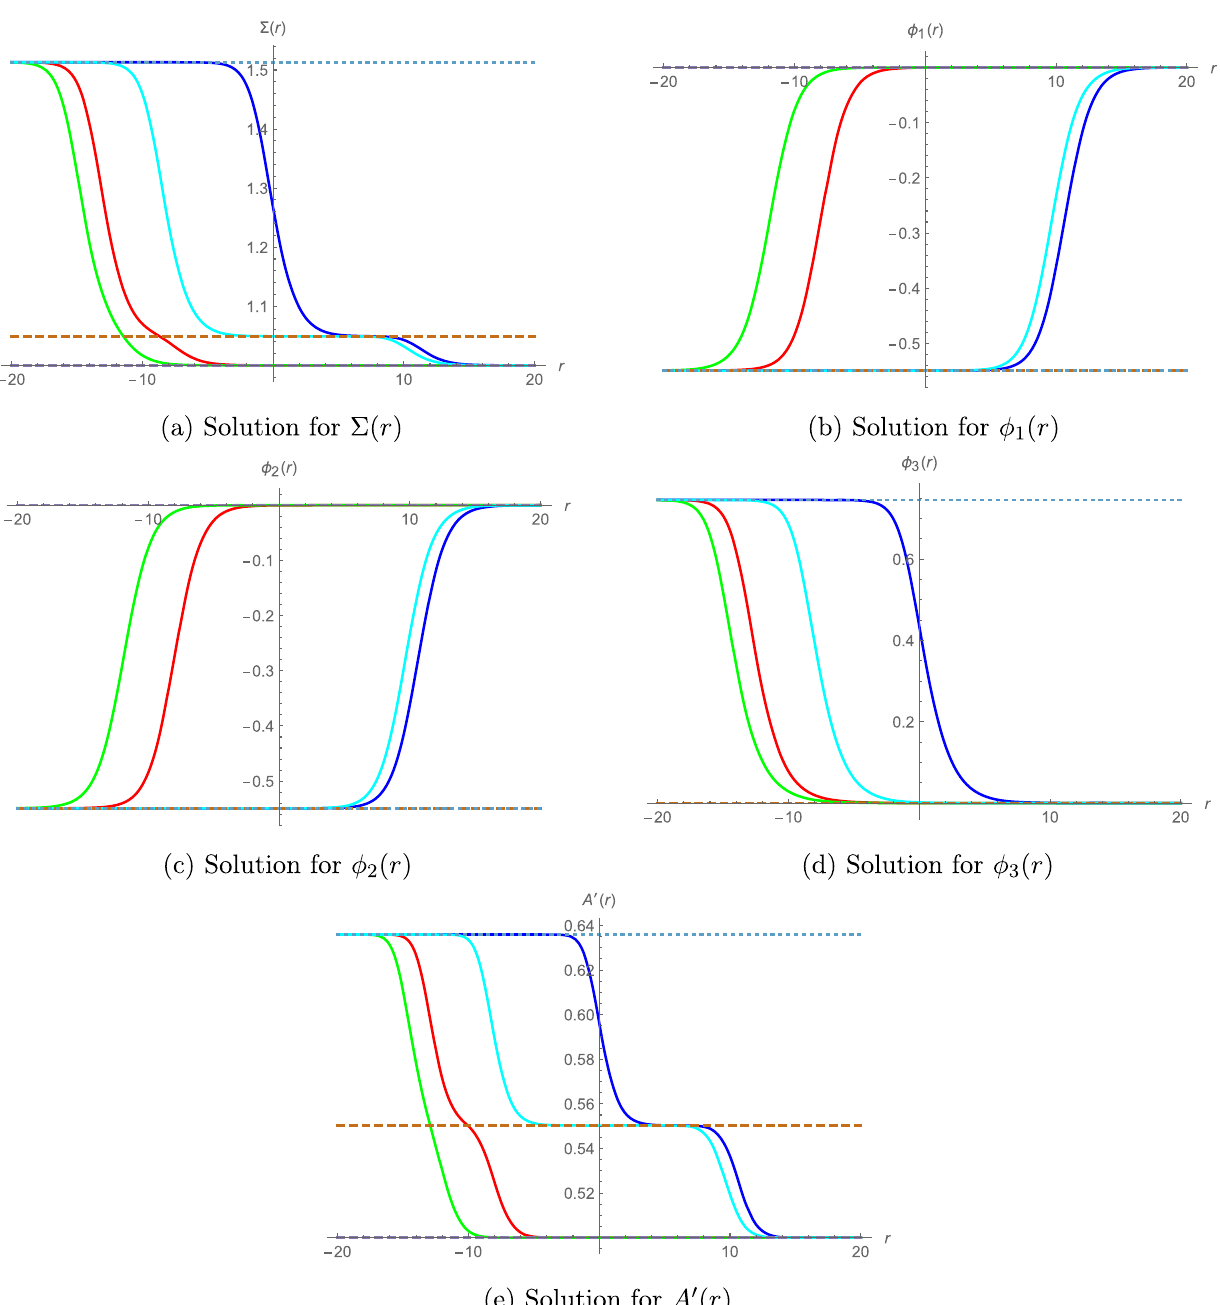
Fig. 1 A family of RG flows from N = 4 AdS 5 critical point with SO ( 2 ) D × SO ( 3 ) × SO ( 3 ) symmetry to N = 2 AdS 5 fixed point with SO ( 2 ) diag symmetry in the IR with g = 1, ρ = 3 and ζ = 1 2 ρ 1 3 with L III = 6 and constants C 1 and C 2 . In this case, g ( 2 + ρ) φ (cid:20) = 2 and φ 1 and 2 are dual to operators of dimensions , 2 + 4 ρ (cid:20) = 6 , respectively. On the other hand, (cid:4) and φ 3 2 + ρ 2 + ρ are dual to combinations of operators of dimensions (cid:20) = as also pointed out in